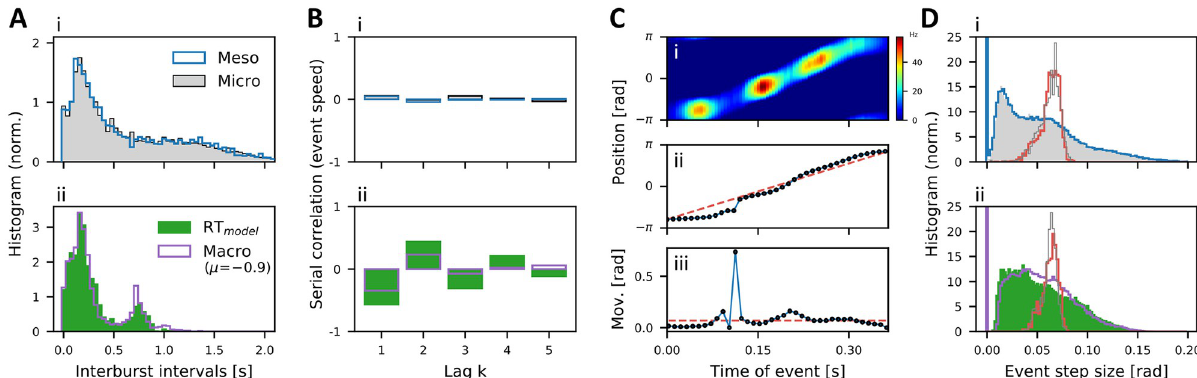
Fig 5. Comparison of fluctuation-induced and depression-induced hippocampal replay dynamics. (A) Interburst-interval distributions and (B) serial correlations of the event speeds of consecutive NLEs for (i) the meso- and microscopic models and (ii) the deterministic models (green: original Romani-Tsodyks model [21], purple: macroscopic model in the fatigue-driven regime obtained by setting N α ! 1 and μ = − 0.9 (instead of μ = − 1.4)). (C) On shorter time scales, all models capture the discontinuous nature of the replayed trajectory: (i) Single NLE of the mesoscopic model. (ii) Place field positions decoded using PVA in bins of 50ms (black dots). This “replayed trajectory” deviates from a straight line (red-dashed) corresponding to a hypothetical uniform motion. (iii) Increments of the movement trajectory exhibit strongly irregular movement features (black dots) in contrast to the constant increments expected for a straight line (red-dashed). (D) (i): The distributions of reconstructed step-sizes of the meso- (blue) and microscopic models (gray histogram) coincide and strongly deviate from the narrow distributions of average step sizes (computed for each NLE by fitting straight lines to individual movement trajectories) for the meso- (red) and microscopic models (gray thin line). The average step sizes vary for different NLE’s, causing the non-zero width of their distribution. (ii) Similar behavior is observed for the macroscopic model (purple; with increased external input μ = − 1.4 7! − 0.9) and the Romani-Tsodyks (RT) model (green histogram); red/gray thin lines correspond to average step sizes in the macro/RT-models, respectively. See main text and Methods for more details.